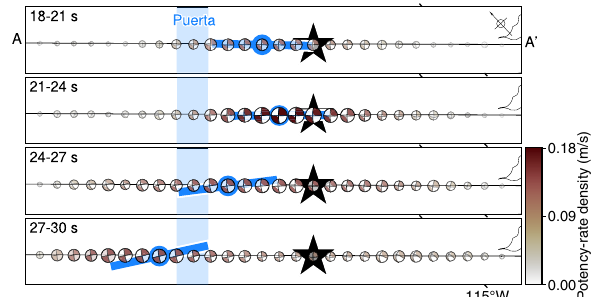
Figure 5. Selected snapshot of potency-rate density tensors at the top of the model plane, projected onto an oblique map of the area along A–A ′ . The blue line indicates the strike of the right-lateral nodal plane for the maximum potency-rate density. The vertical blue-shaded bar shows the Puerta accommodation zone 12 . The star denotes the epicentre used for the inversion. This figure was made with Generic Mapping Tools (v6.2.0) 18